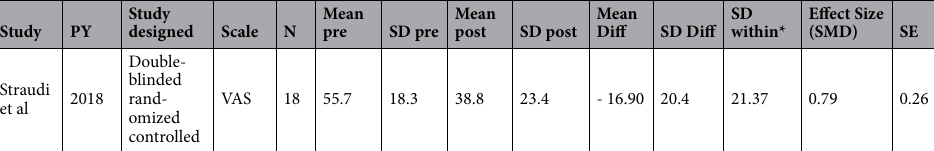
Table 12. Pain. Real. *the correlation, r = 0.547, between pre-post data were extracted from the variance of the difference. PY = Publication Year SD = Standard Deviation. SMD = Standardized Mean Difference. SE = Standard Error.